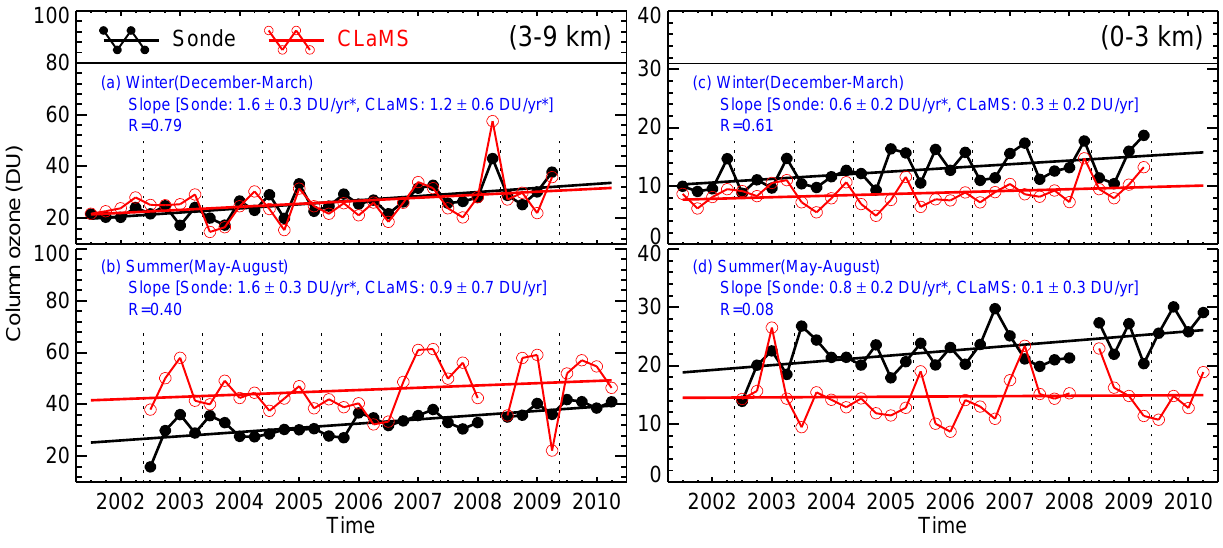
Fig. 4. Trends of monthly mean partial column ozone for 3–9km layer and 0–3km layer in winter (December–March) and summer (May– August) from observation (Sonde) and simulation (CLaMS) during 2002–2010. The numerical values for the slopes with symbol “*” pass the 95% significance criterion. The number R is the correlation coefficient between observation and simulation. There were no observations available during August 2008.